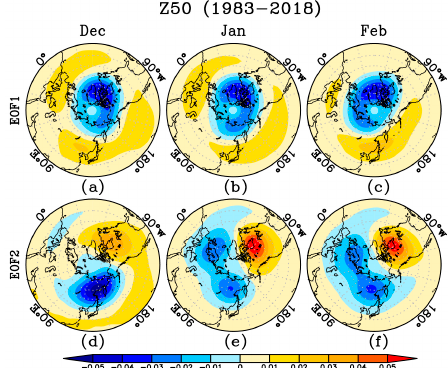
Figure 8. The first ( a – c ) and second ( d – f ) leading mode of geopotential height at 50 hPa in December ( a , d ), January ( b , e ), and February ( c , f ).